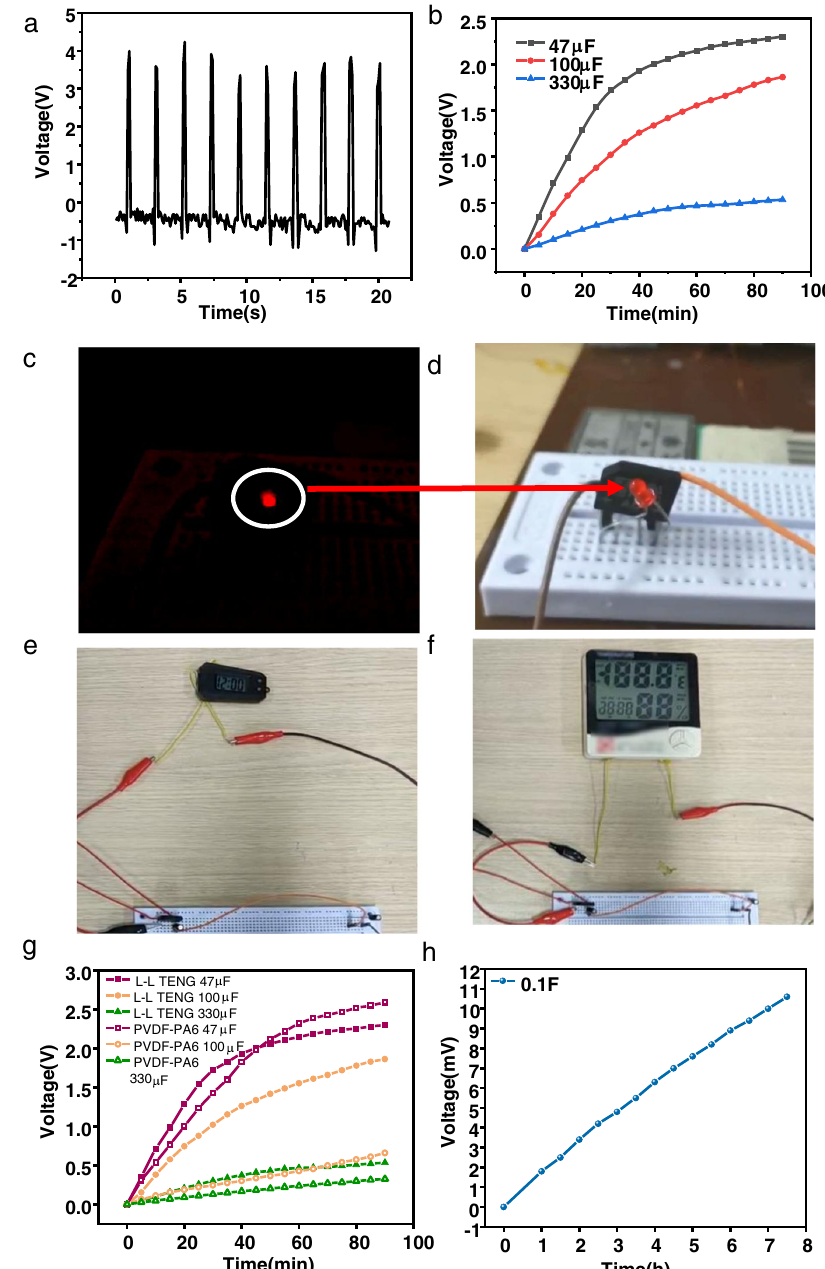
Fig. 5 | Applications of the L-L TENG. a Open-circuit voltage generated by 10 L-L TENGs connected in series. b Charging curves for commercial capacitors of 47 μ F, 100 μ F,and330 μ F. c , d TheseriesofL-LTENGscoulddirectlylightanLED.The( e ) electronic meter and ( f ) hygrometer could be powered by the series of L-L TENGs.